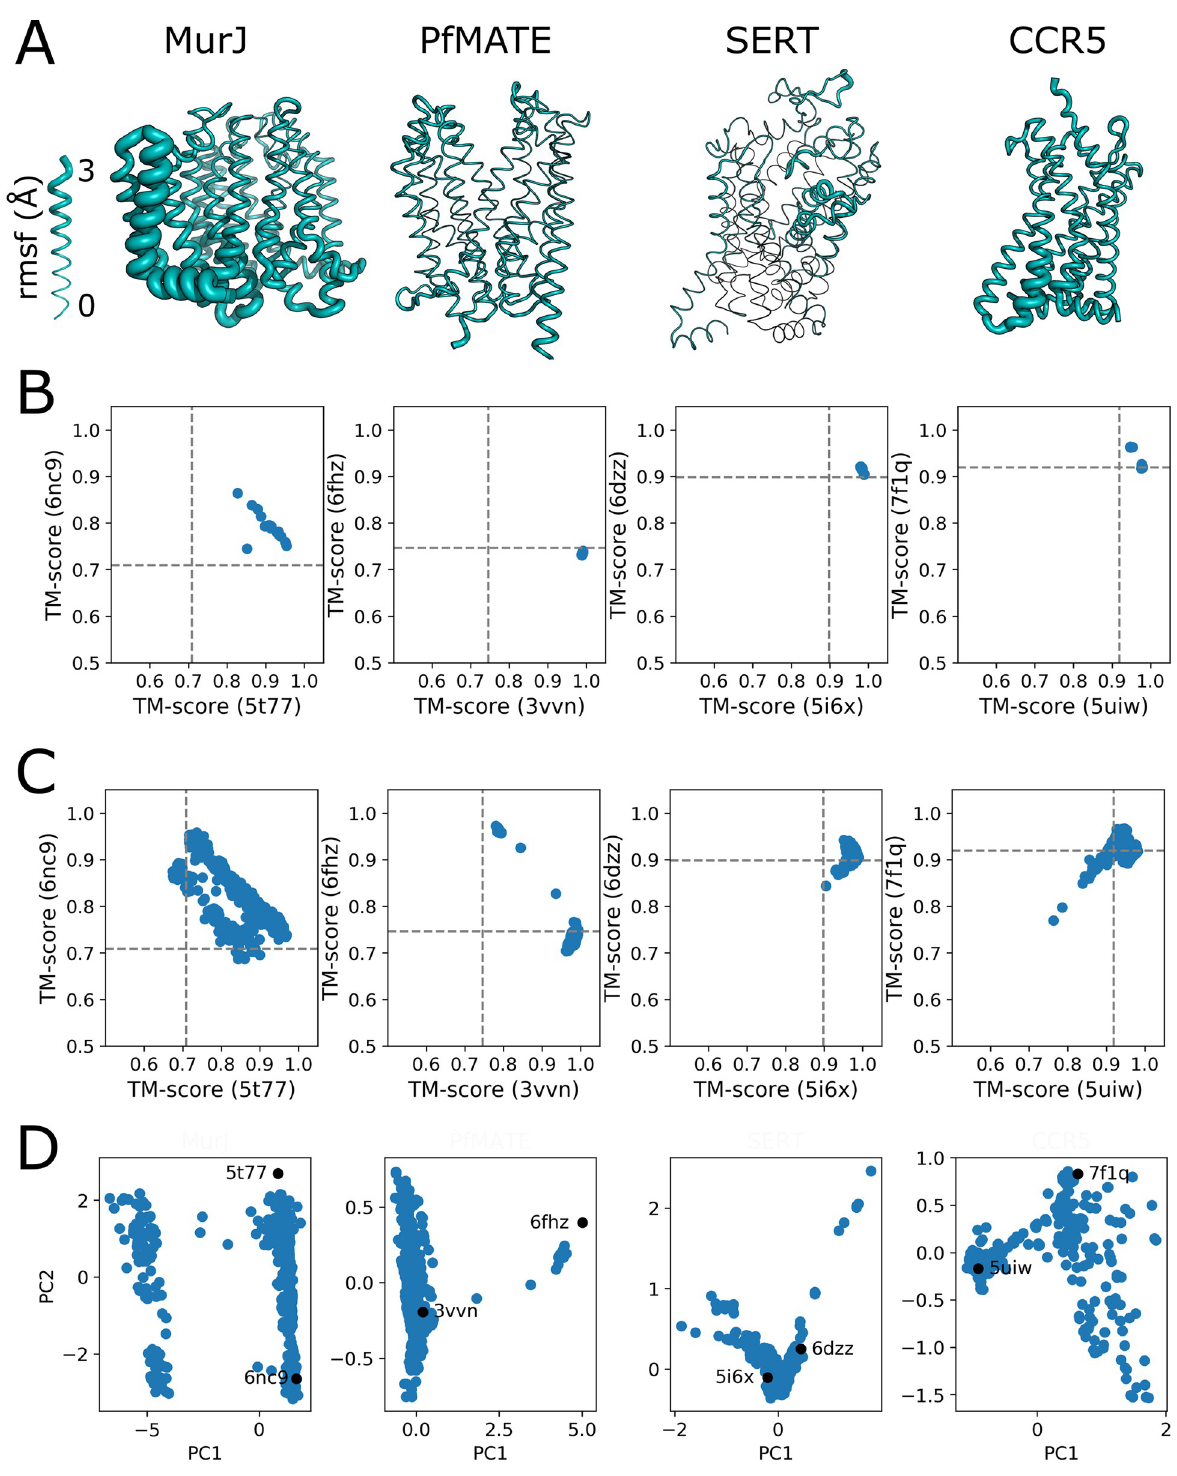
Fig 5. Sampling conformational flexibility of proteins with one structure in AF2 training set. A) Models with the thickness of the chain based on the rmsf for the 15 AF2 models from the unmodified MSA. B) TM score plot for the 15 initial models. C) TM score plot for all models after parsing for molprobity score. D) PCA of the parsed models. In Fig F in S1 Text are plots of the experimental structures and the best model based on TM score.